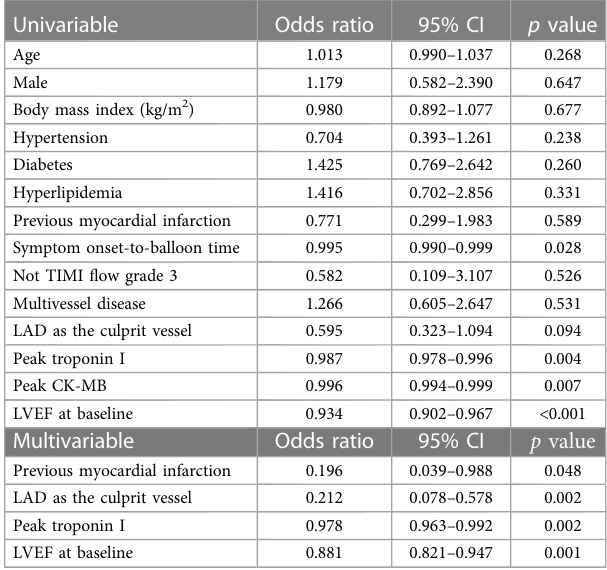
TABLE 4 Logistic regression analysis for the left ventricular recovery.